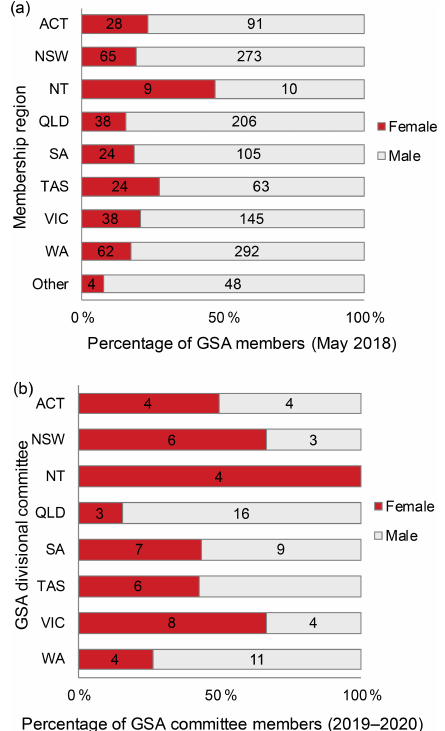
Figure 4. (a) Gender balance of members within the Geological Society of Australia (GSA) by State or Territory in May 2018. Aus- tralia Capital Territory (ACT), New South Wales (NSW), Northern Territory (NT), Queensland (QLD), South Australia (SA), Tasma- nia (TAS), Victoria (VIC), Western Australia (WA), Other: mem- bers located overseas. The Hunter Valley Branch is grouped within the NSW data. Membership numbers by headcount are displayed within the chart. (b) GSA Divisional Committee members by gen- der for the current period